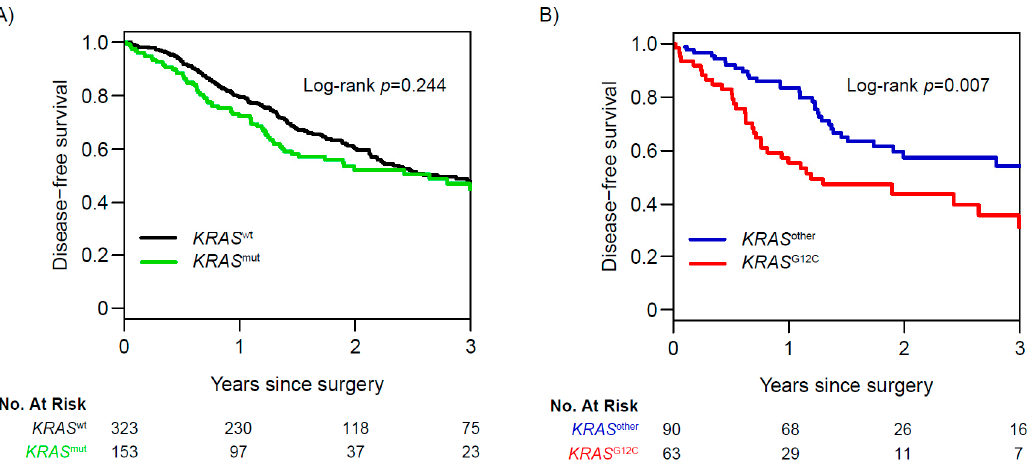
Figure 4. Association between KRAS mutation status and disease-free survival (DFS) in The Cancer Genome Atlas cohort ( N = 476). ( A ) Three-year DFS for all KRAS mutant ( KRAS mut ) tumors versus KRAS wild-type ( KRAS wt ) tumors. ( B ) Three- year DFS for KRAS G12C tumors versus all other KRAS mutant tumors ( KRAS other ). (From Clinical Cancer Research , Jones,